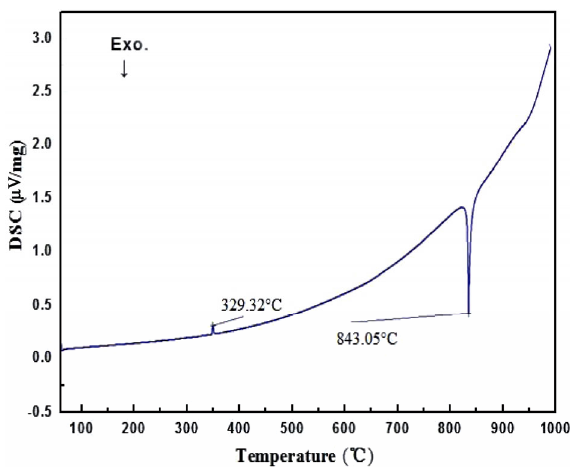
Fig. 7 XRD pattern of sample D after ball